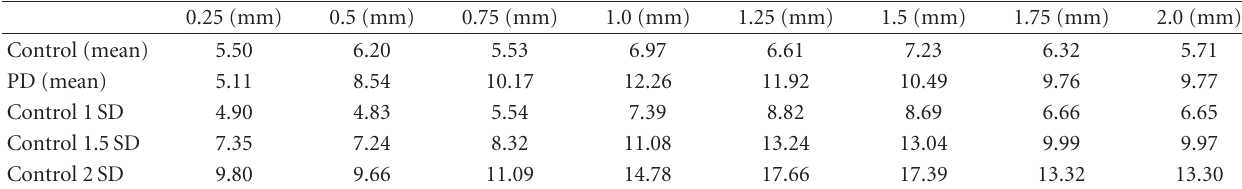
Table 1: Interocular thickness di ff erence (microns) and SDs (1, 1.5, and 2) by radial distance location (mm from foveola) in PD patients and controls.